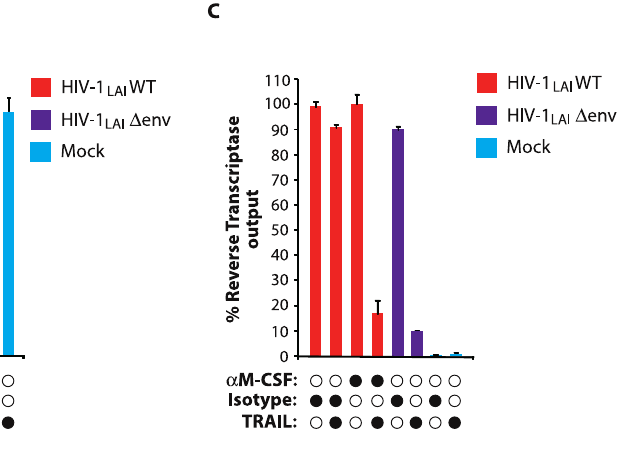
Figure 3. M-CSF Modulates TRAIL-R1 Expression (A) HIV-1 wild-type–, D env-, or mock-infected macrophages were analyzed by flow cytometry 16 h after treatment with recombinant M-CSF (5,000 pg/ ml (cid:2) 1 ) or with a neutralizing antibody to M-CSF (error bars, SD). (B,C) HIV-1 envelope is required for the resistance of infected macrophages to TRAIL. HIV-1 wild-type– and D env-infected macrophages were incubated with neutralizing antibody to M-CSF for 16 h. Cultures were then treated with soluble TRAIL (100 ng/ml (cid:2) 1 ). Cell viability (B) and virus output (C) were determined after 24 h by MTT assay and RT production, respectively.